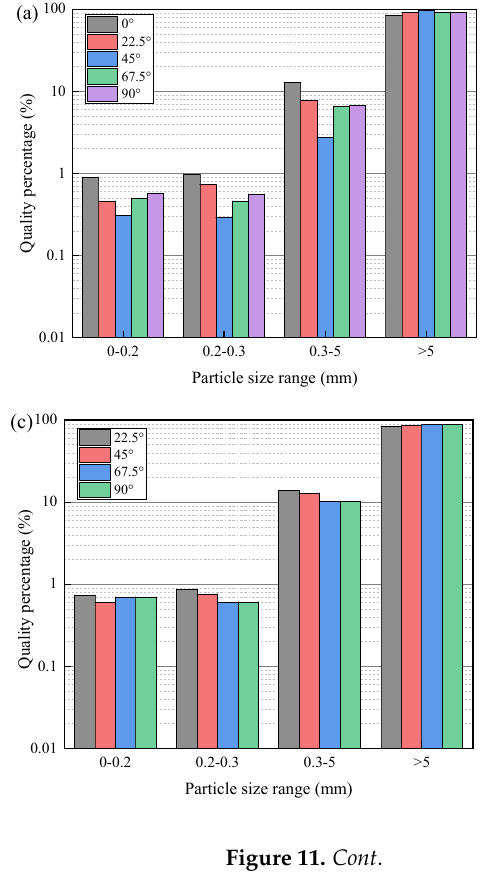
Figure 10. Stress component on the diameter ON.